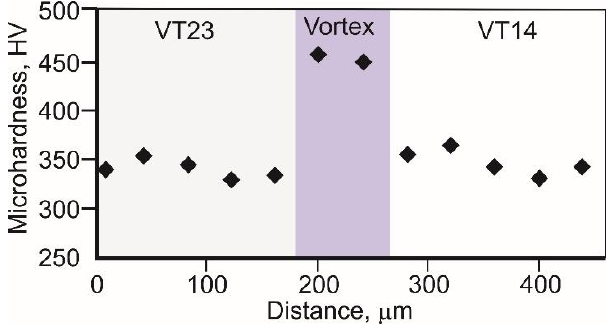
Figure 8. Results of microhardness measurements of the material near the interface between titanium alloys.